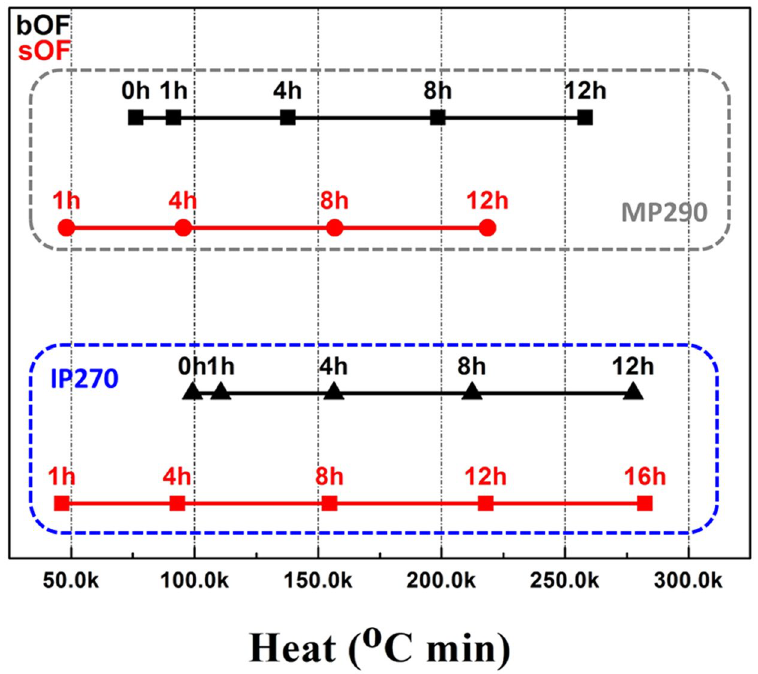
Figure 3. Heat absorption calculated by equation (1) for the experimental OFs. The red and black lines represent sOFs and bOFs,